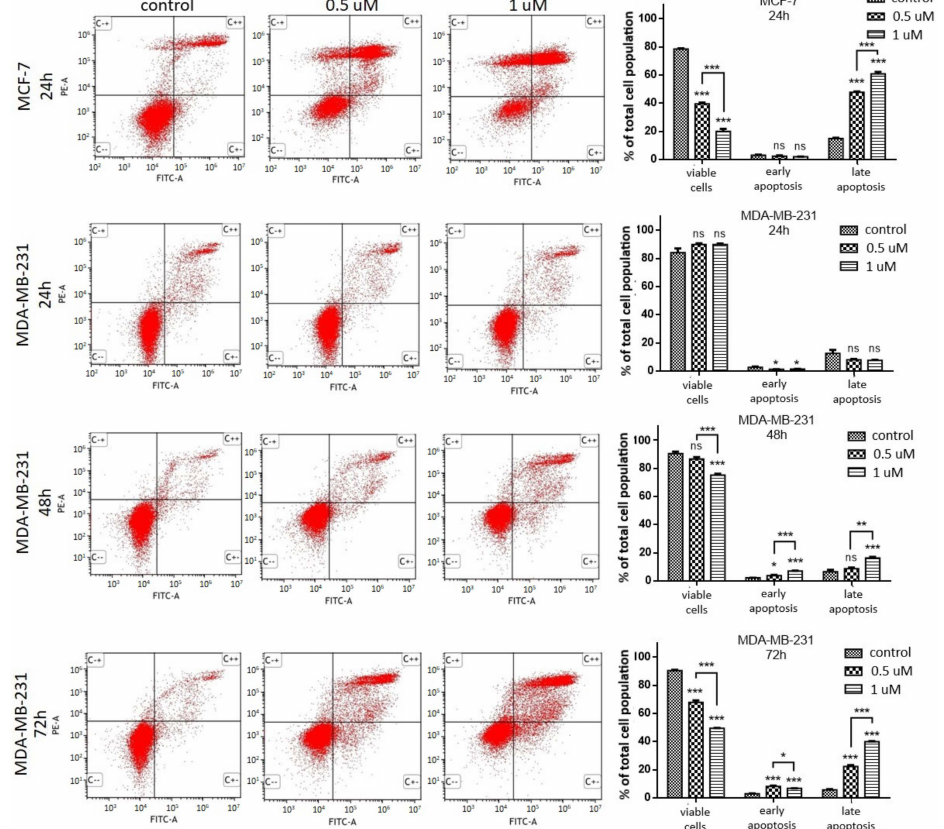
Figure 4. Induction of apoptosis by AJ-418 in MCF-7 and MDA-MB-231 cells. Cells were exposed to the tested compound at 0.5 µ M and 1 µ M concentrations, MCF-7 for 24 h and in MDA-MB-231 for 24, 48 and 72 h, then stained with annexin V and PI and analyzed using flow cytometry. Representative cytograms and quantification of apoptotic cell death are shown in the figure; each column represents the mean ± SEM of three independent experiments; * p < 0.05, ** p < 0.01 and *** p < 0.001 were considered statistically significant compared to controls, ns—no statistical